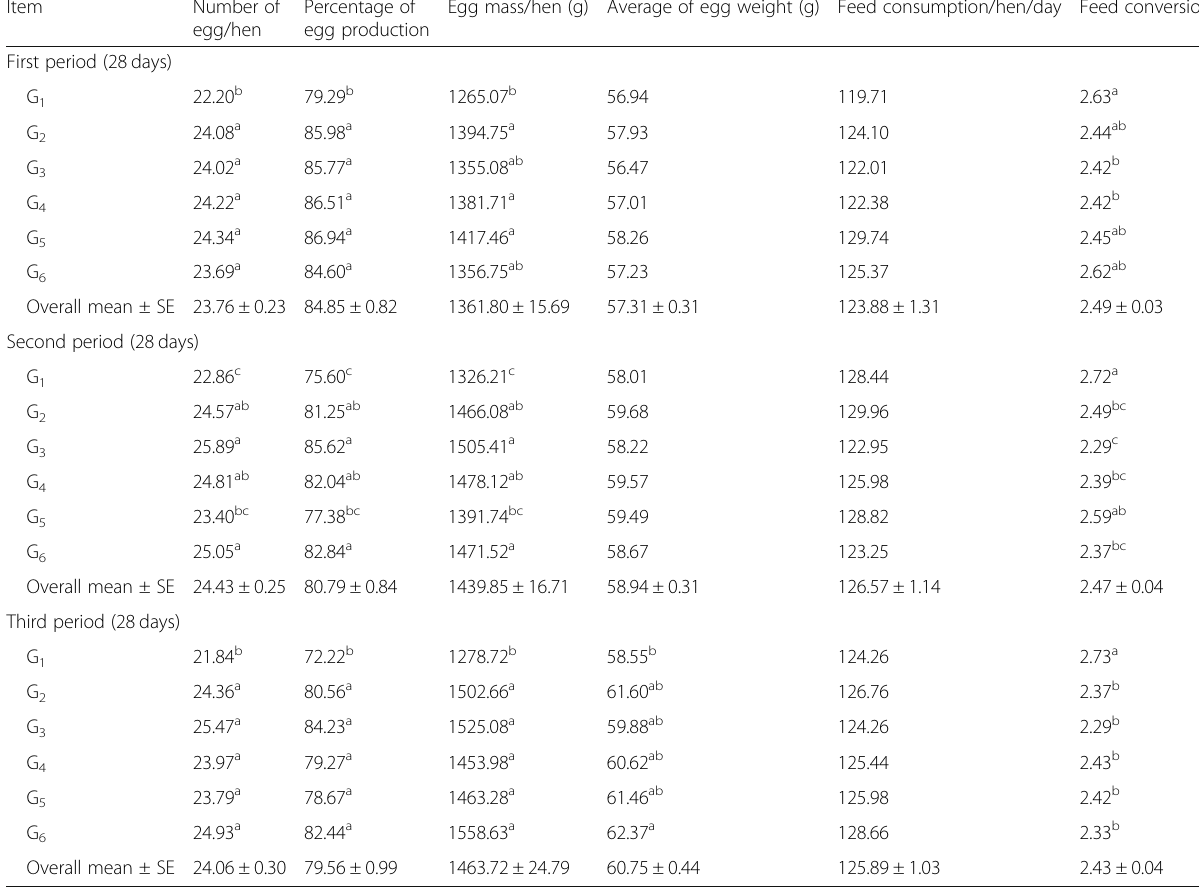
Table 3 Effect of dietary treatments on laying hen performance Item Number of egg/hen